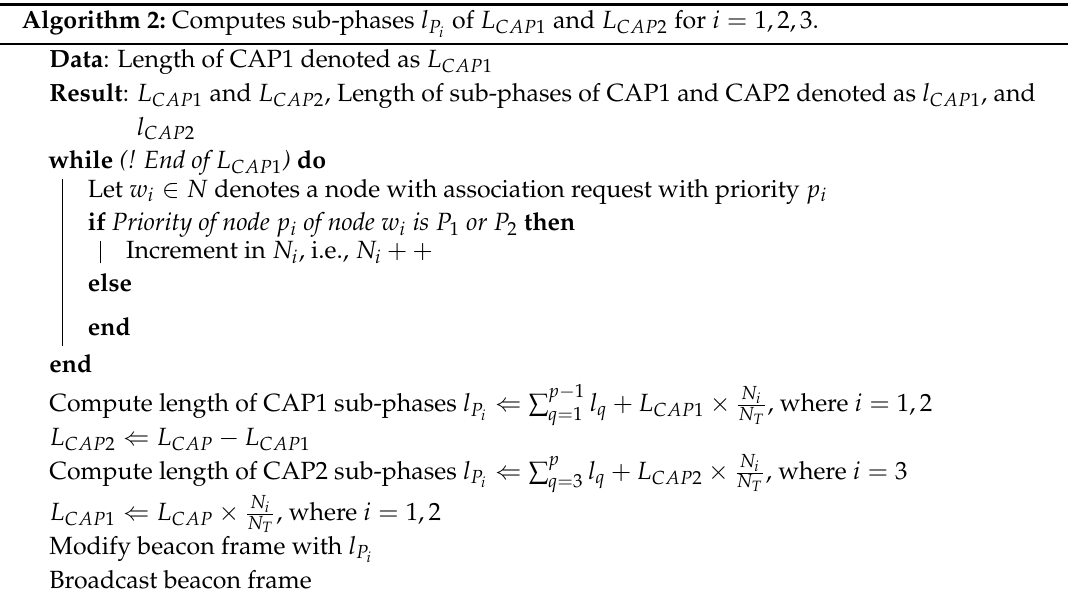
Algorithm 2: Computes sub-phases l P Data : Length of CAP1 denoted as L CAP 1